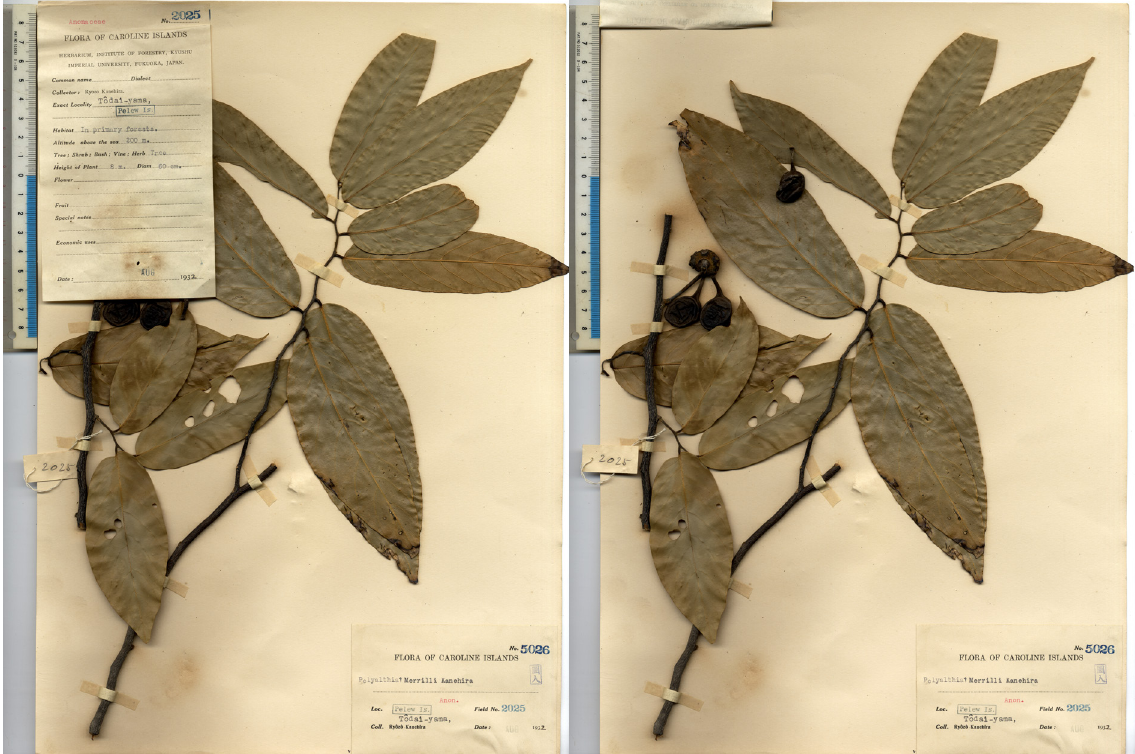
Fig. 15. Lectotype of Polyalthia merrillii Kaneh. Right-hand image has the label folded back to reveal the obscured parts of the specimen. Images provided by the Herbarium of Kyushu University (FU),